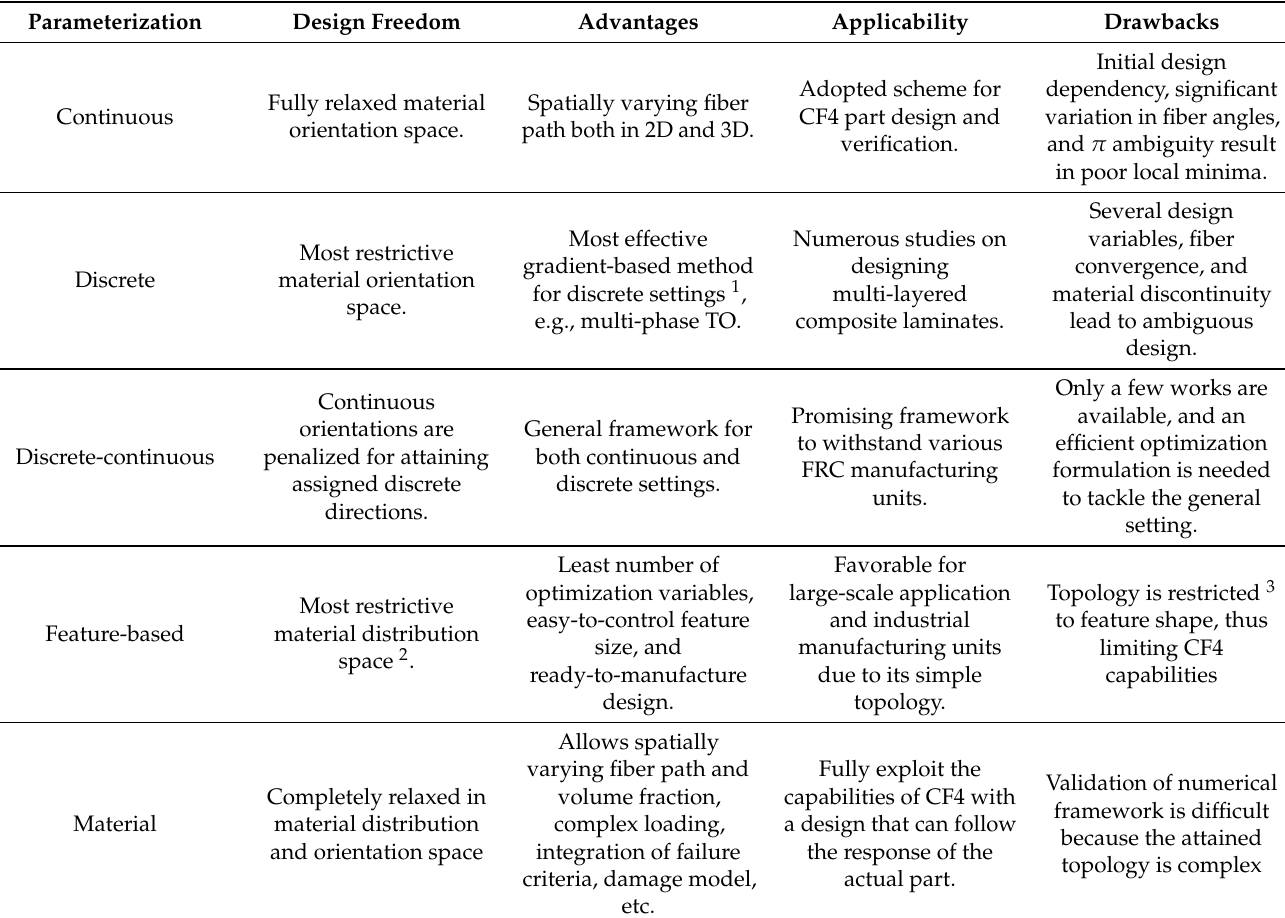
Figure 5. The example demonstrates the design of MBB using the geometry projection method (adapted from [121]). The top of the left column shows the MBB beam design region, support, and unit load, whereas the bottom depicts colored penalized element densities for the optimal MBB beam designs. Note that the color denotes the orientation of the rest of the changes. In the right column, iteration histories of an objective function indicate the attained compliance value f ( i ) at an iteration i . Table 1. Various attributes and comparison of enumerated parameterization